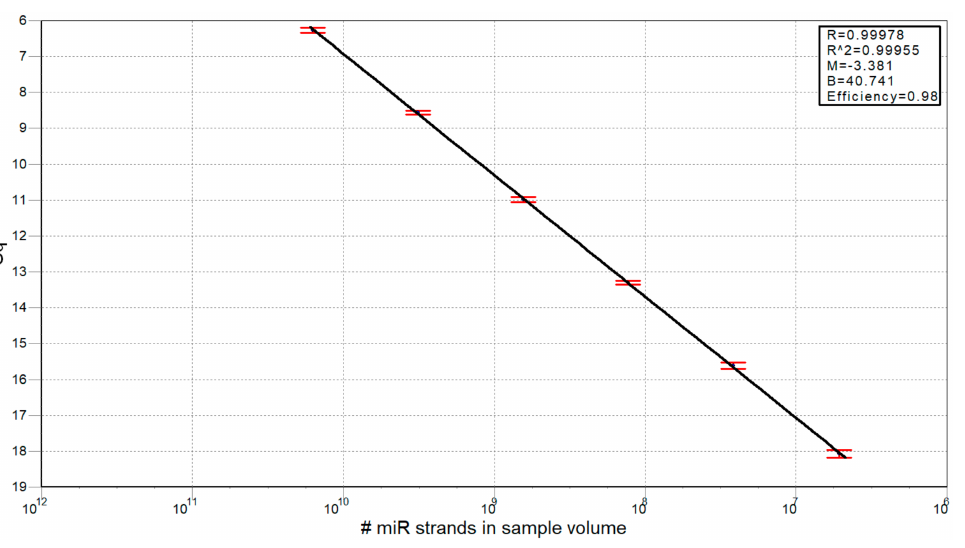
Figure A1. Spatial characterization of reconstituted/labeled lipoprotein particles. High-speed atomic force microscopy (HS-AFM) images of reconstituted HDL particles ( a ), rHDL particles with miR-155 & spermine ( b ), labeled LDL particles ( c ) and labeled LDL particles with miR-155 & spermine ( d ). The size analysis yielded distributions of particle heights for native HDL particles (N = 125 particles, <height> = 7.3 nm ± 1.5 nm), rHDL particles (N =110, <height> = 5.5 nm ± 1.0 nm) and rHDL particles + miR-155 & spermine (N = 122, <height> = 5.5 nm ± 0.9 nm) ( e ), as well as for native LDL particles (N = 79, <height> = 16.1 nm ± 2.4 nm), labeled LDL particles (N = 89, <height> = 17.2 nm ± 3.4 nm) and LDL particles + miR-155 & spermine (N = 57, <height> = 18.8 nm ± 2.4 nm) ( f ).